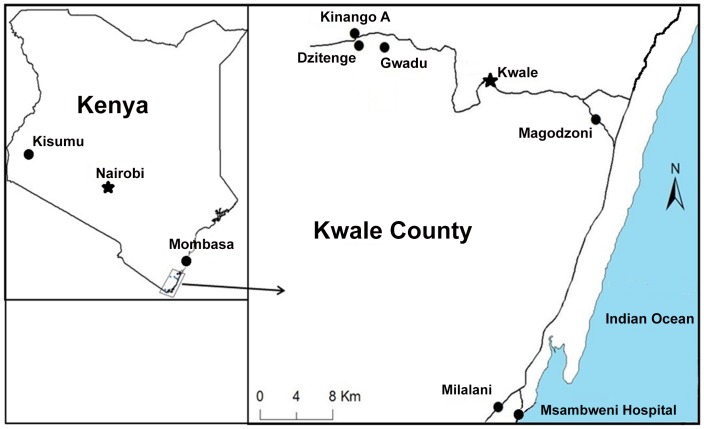
Map of the study area showing location of study villages in Coast Province, Kenya.